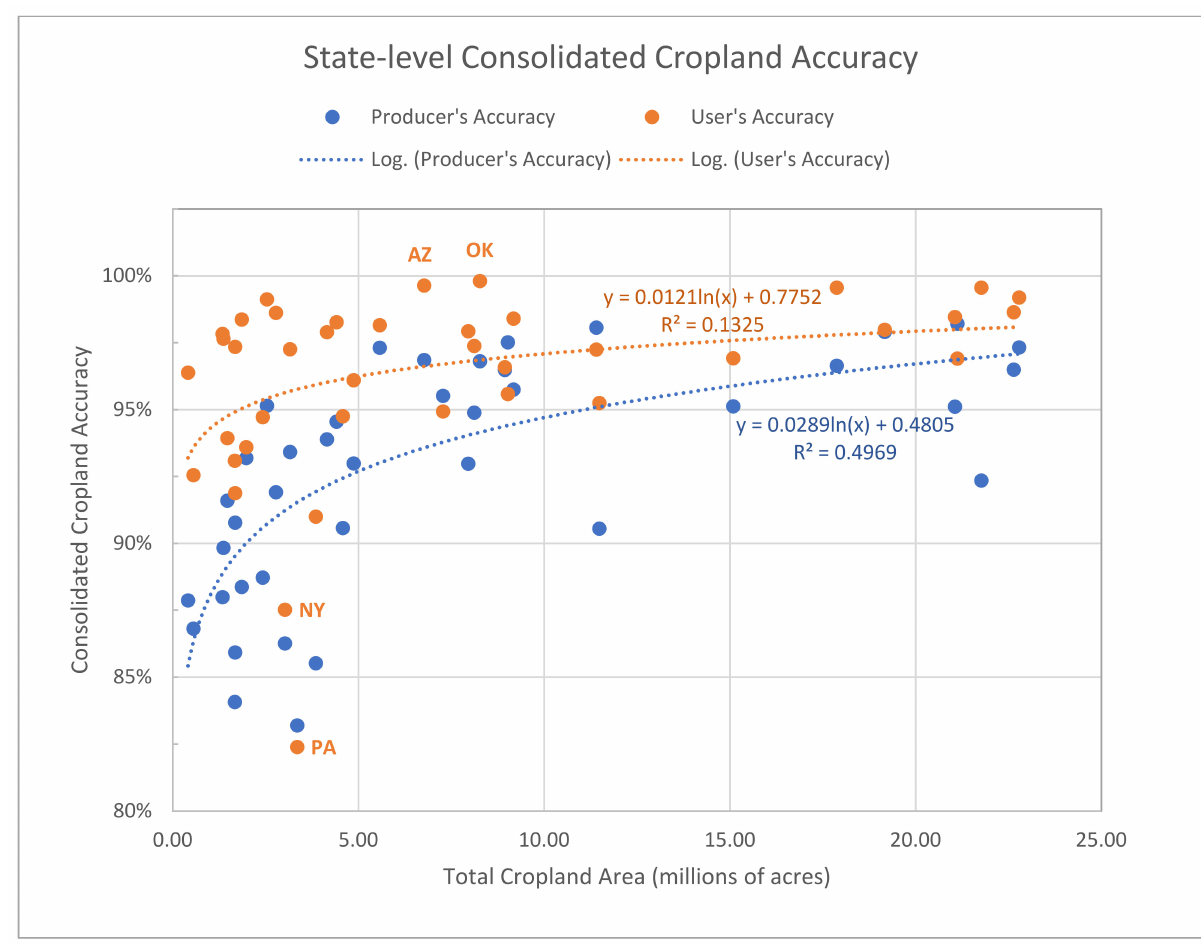
Figure 1. Plot of consolidated cropland user and producer accuracies for each state for 2012. Accuracies plotted against total crop area in each state. States with greater amounts of cropland typically had higher consolidated cropland accuracies. Plotting accuracy against the proportion of cropland within each state generated similar trends (data not